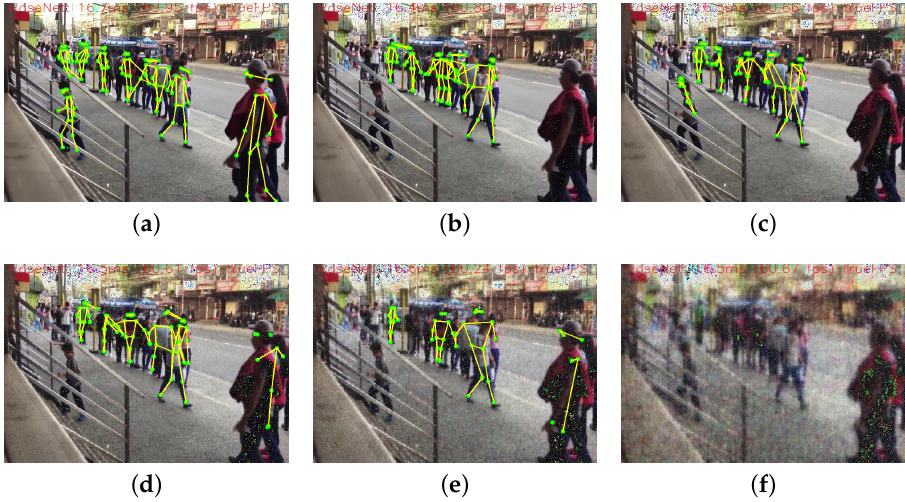
Figure 4. Outputs of the PoseNet model for video resolution of 640 × 480: ( a ) original image, ( b ) CS rate of 90%, ( c ) CS rate of 70%, ( d ) CS rate of 50%, ( e ) CS rate of 30% and ( f ) CS rate of